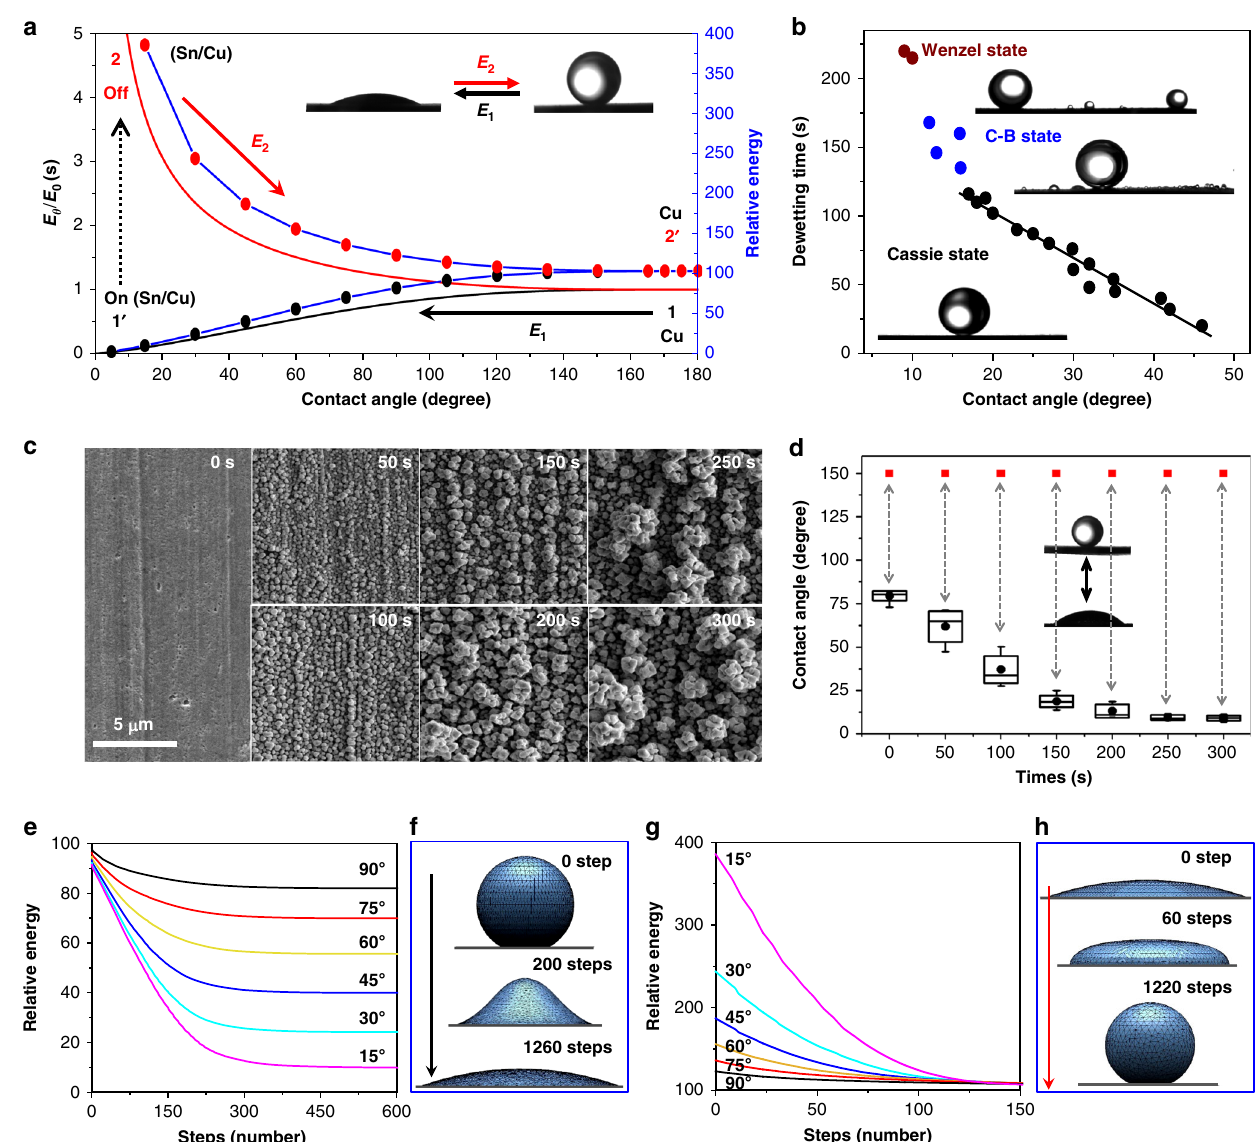
Fig. 3 The theoretical calculation and the wetting transition within different ranges. a The surface energy index of a droplet with various contact angles (CAs) by the theoretical calculation (solid curves) and by the hybrid-energy-minimization (HEM) calculation (dotted curves). E 0 is the initial surface energy of a droplet with a CA of 180°, and E 1 and E 2 are the surface energies of droplets with CA transitions from ~180° to ~0° and from ~0° to ~180°, respectively. b Three typical wetting states involved in the in situ reversible superwetting transition: Cassie wetting, Cassie – Baxter wetting, and Wenzel wetting. c Scanning electron microscopic images of Cu electrodes with different roughnesses obtained by varying the electrochemical deposition time of Cu from 0, 50, 100, 150, 200, 250 to 300 s. d The wetting transition can be varied between the superoleophobic (CA > 150°) state and a wide range of oleophilic (CA from ~78° to ~0°) states on the surface with different roughnesses. The data are presented as box-and-whisker plots; box, 25th – 75th percentile; whiskers, 5th and 95th percentile expansion; solid black circle, mean. e , f Variations in the relative total surface energy of a 5-pL droplet with an initial CA of 150° released on a homogeneous surface with different wettability values (with CAs of 15°, 30°, 45°, 60°, 75°, and 90°) as a function of the number of steps for the HEM calculation. g , h Variation in the relative total surface energy of a 5-pL droplet placed on a homogeneous surface with a CA of 150° as a function of the number of steps for the HEM calculation. The initial CAs are 15°, 30°, 45°, 60°, 75°, and 90°,